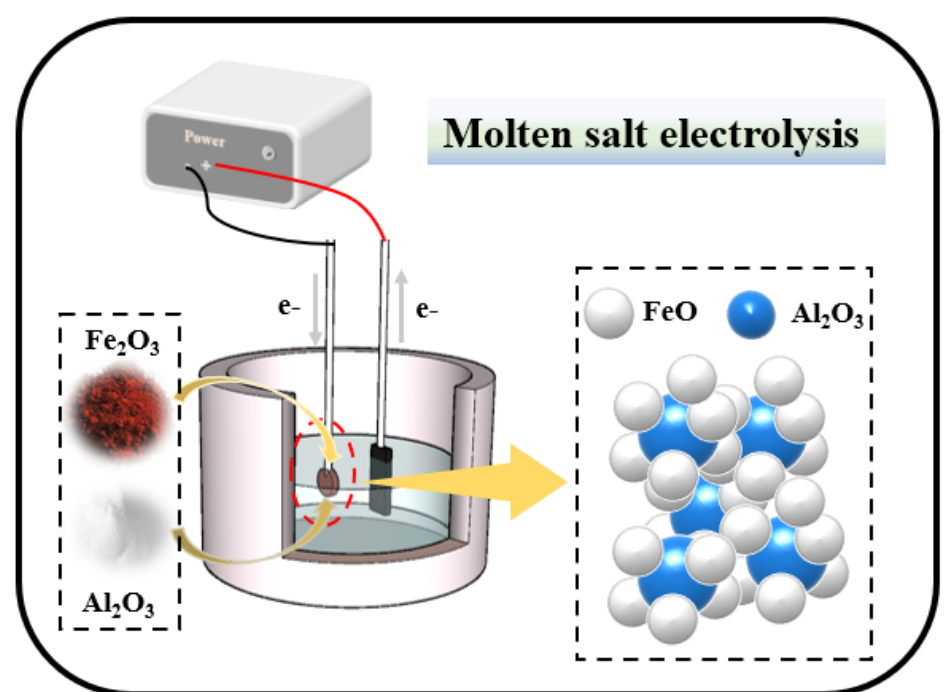
Figure 2. Schematic diagram of electrolysis process.